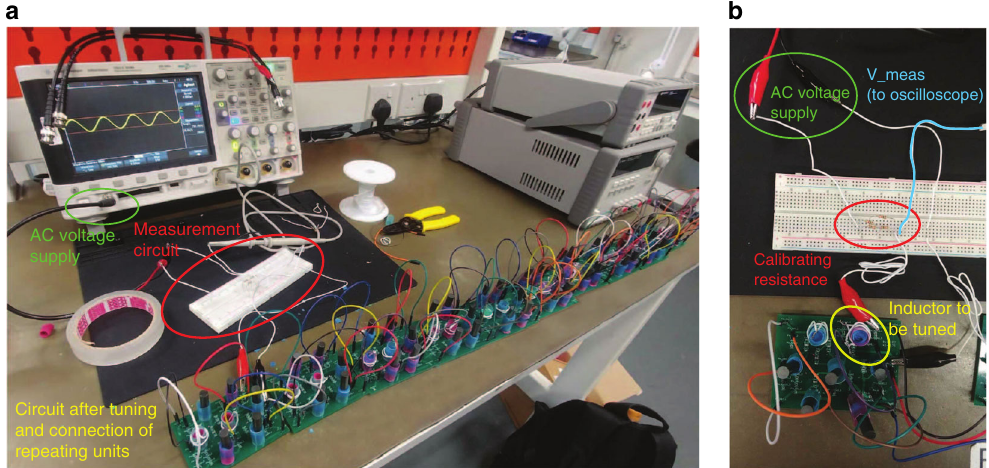
Fig. 10 Experimental setup for impedance measurement. a Full view of setup for impedance measurement of the complete circuit array. The oscilloscope generates the AC voltage signal for the impedance measurement, as well as for tuning each variable inductor of each coupling unit (logical component). Schematics of the circuits are described in Figs. 9 and 6. b Close up of measurement circuit with AC voltage supply, test resistor forming a voltage divider, inductor currently being tuned, and wire connecting to oscilloscope to measure voltage across the coupling of each measured point was 0.2, and the coef fi cient of correlation between simulated and measured data were 0.743. When excluding three points (ky,kz) = (0.9, 1.28), (0.96, 1.07), (0.07, 1.26), which according to simulation are in regions with very high local variance within a small k radius around those points (see Fig. 7b, c, and Supplementary Tables 4, 5, and 6), the coef fi cient of correlation increases to 0.863. These relatively unstable points were chosen for measurement in order to map a complete ring around the drumhead, but are dif fi cult to measure due to the extreme variance in the region k z > 1.0. With larger circuits with much higher N , for example N = 30, the region k z >1.0 becomes easier to measure due to reduced variance at higher N (see Fig. 5a.). Machine learning assisted selection of sampling points: To minimize the effect of uncertainties and reduce the number of ( k y , k z ) points needed to reconstruct a prominent drumhead region of elevated impedance, we used a Nearest-Neighbor machine learning algorithm to select ( k y , k z ) sampling points which are optimally impervious to capacitor and inductor uncertainties, see Fig. 8. This is important for reducing experimental costs, as well as reducing the impact of inevitable component uncertainties. We associate each sampling point with Z avg , which is the impedance of a particular k y , k z point averaged over a large number of randomly generated